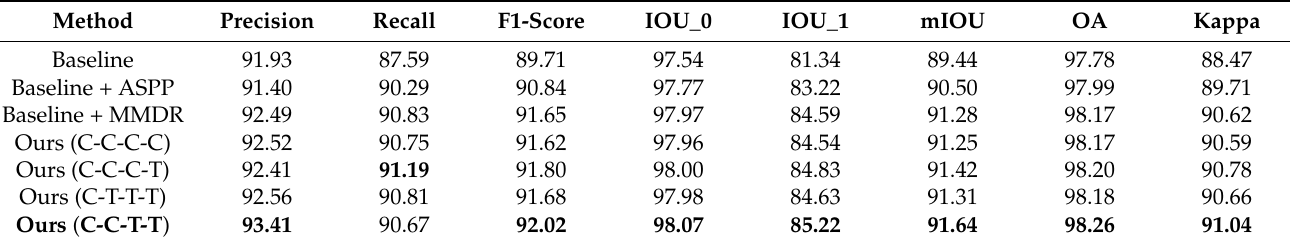
Table 2. The results of ablation experiments on the LEVIR-CD